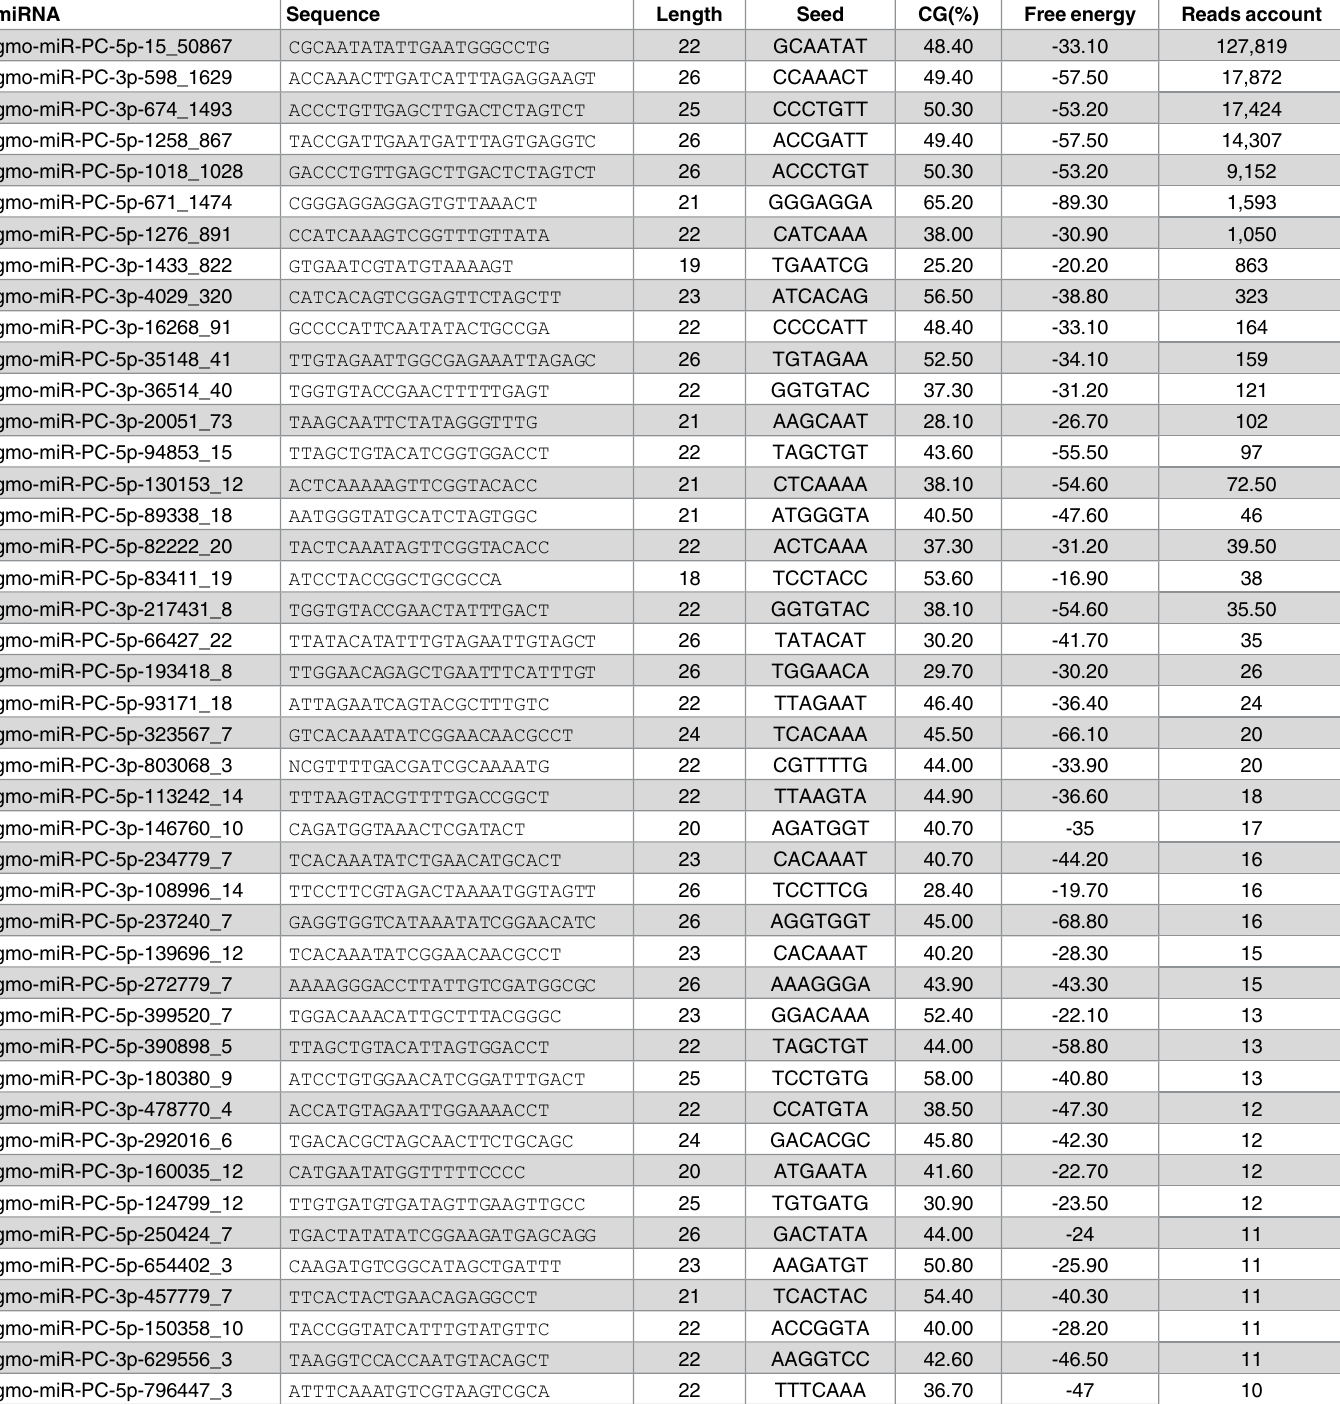
Table 3. Novel miRNAs in G . molesta .